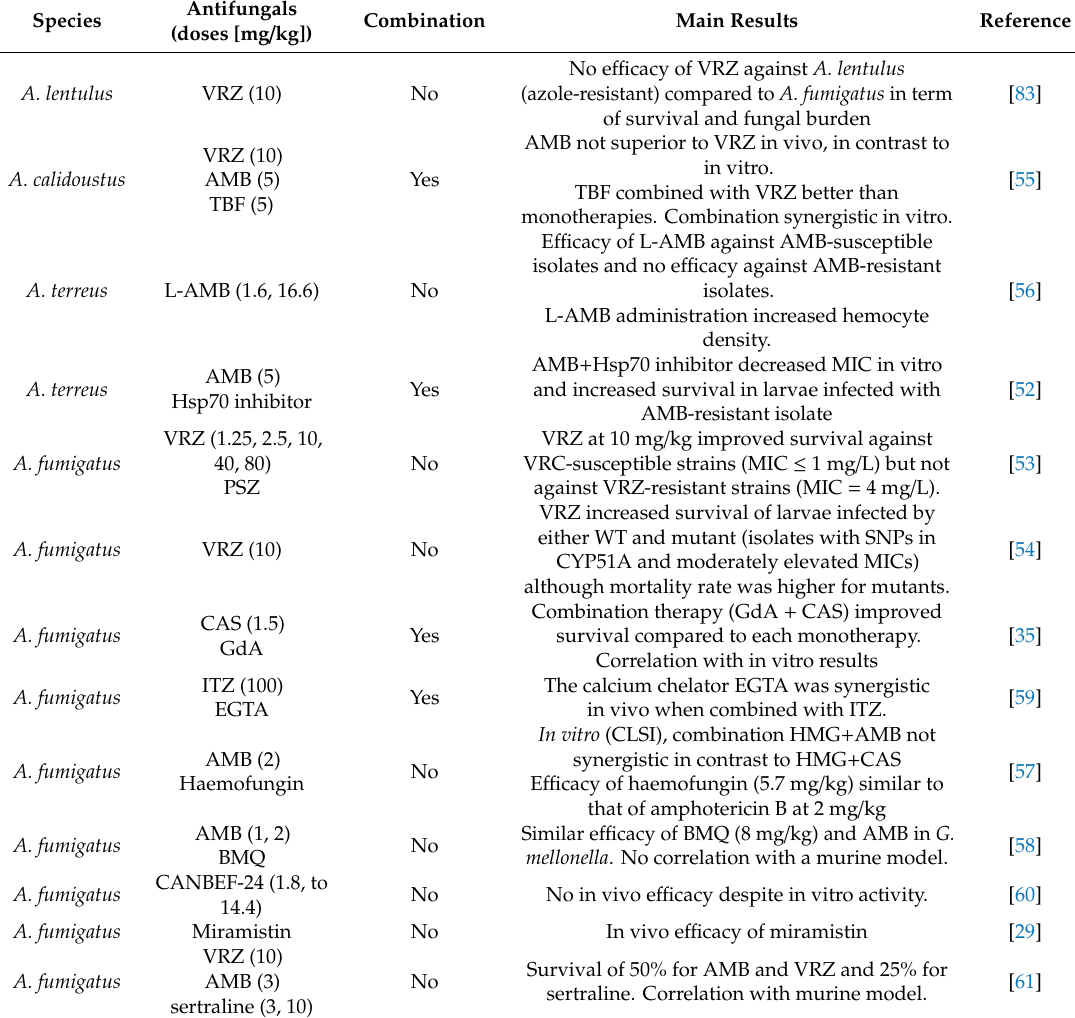
Table 4. Evaluation of antifungal treatment against Aspergillus spp. in Galleria mellonella . Antifungals Combination Main Results Species (doses [mg / kg])